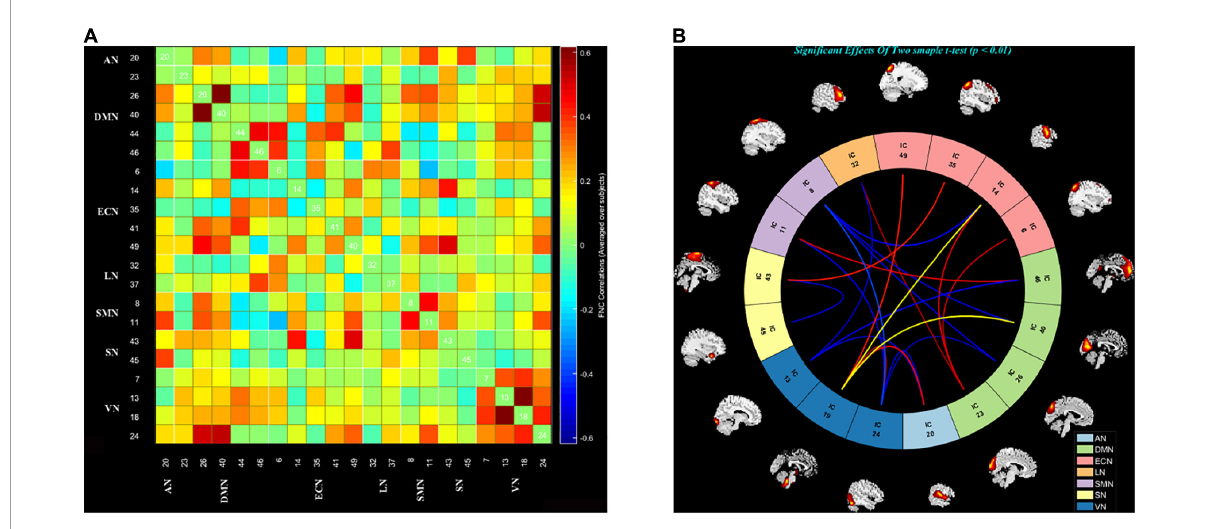
FIGURE2 The static functional network connectivity results. (A) The average static functional network connectivity matrices of all subjects between ICs pairs were produced in entire resting state time courses. (B) The difference of static functional network connectivity between two groups in seven networks (two sample t -tests) ( p < 0.01, FDR). AN, auditory network; DMN, default mode network; ECN, executive control network; LN, language network; SMN, sensorimotor network; SN, salience network; VN, visual